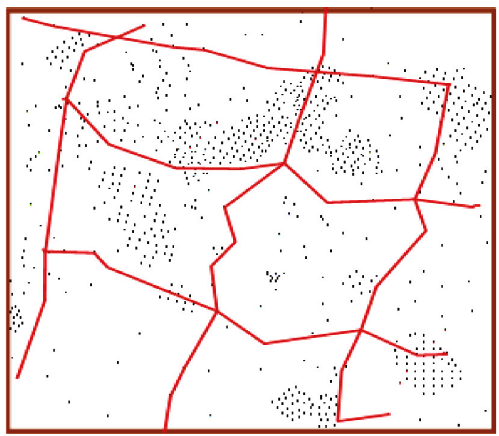
Figure 5: “ Three horizontal and three vertical ” typical reservoir pro fi